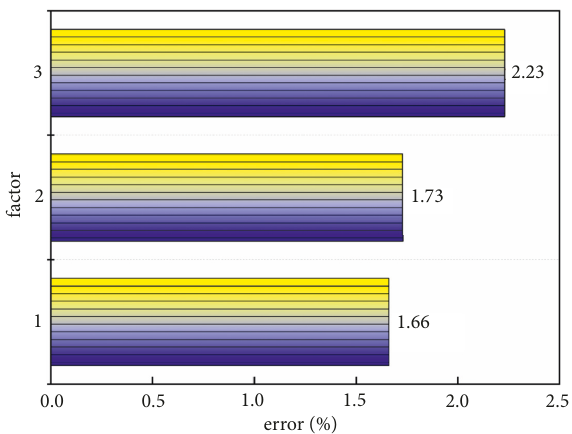
Figure 5: Prediction errors of three characteristics of music teaching effect using hybrid CNN-LSTM method.